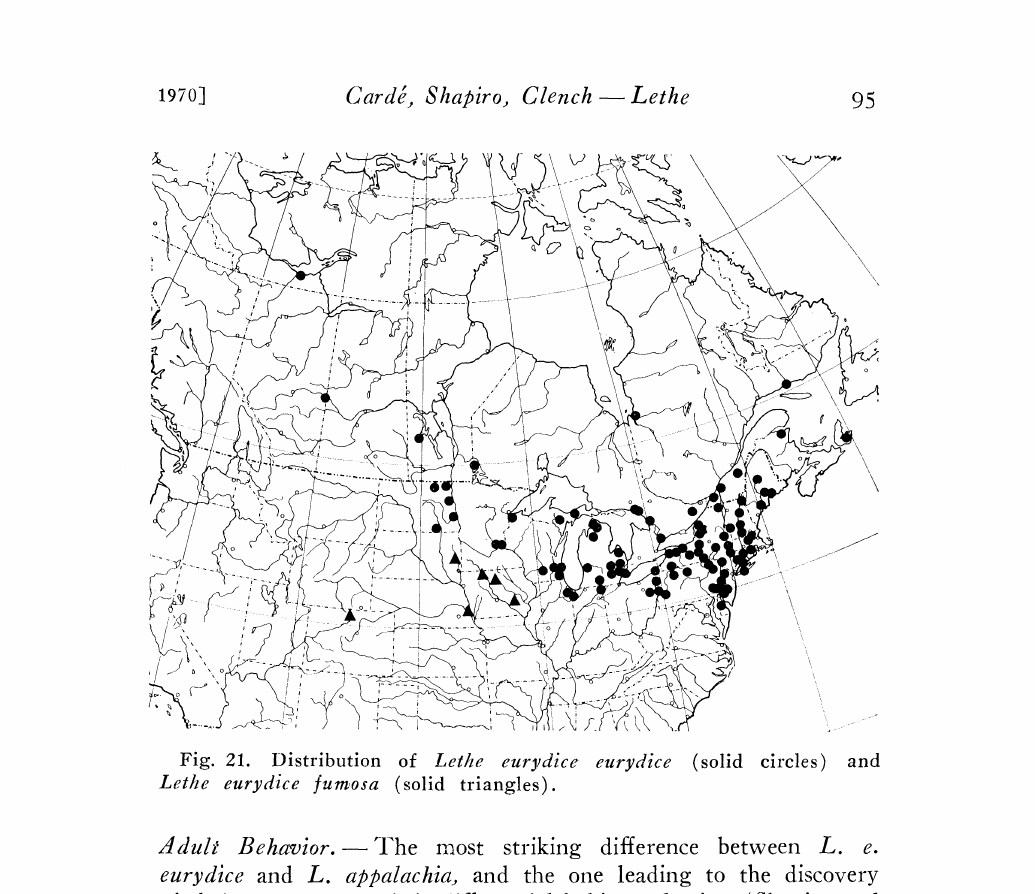
Fig. 21. Distribution of Lethe eurydice eurydice (solid circles) and Lethe eurydice fum, osa (solid triangles). Adult Behavior.-- The most striking difference between L.